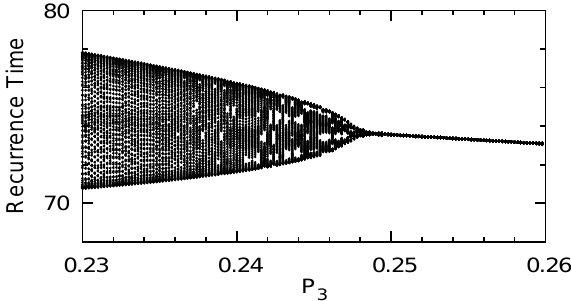
Figure 9. Bifurcation diagram of recurrence intervals of slip events at Block 1 near the transition to pattern 2. The model parameters are K = 1.00, P 1 = 0.650, and P 2 = 0.500, and 0.23 ≤ P 3